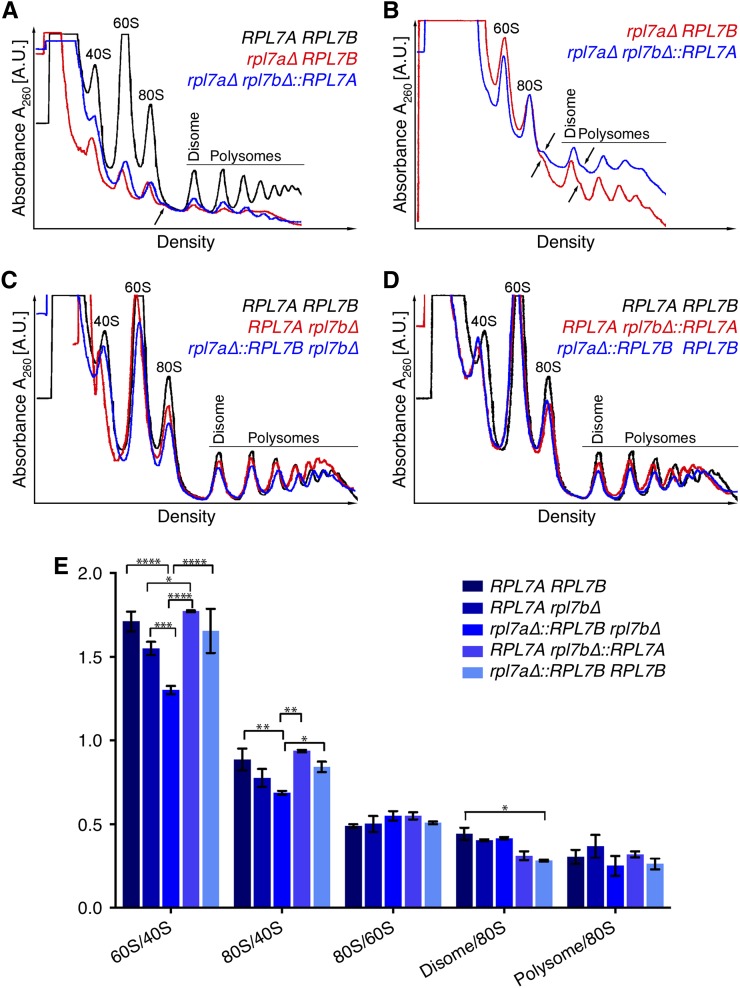
Primarily the RPL7 locus, but also the Rpl7 and snR39/59 isoforms expressed, contributes to differences in polysome profiles. Polysome profiles of cell extracts from strains of the indicated genotype grown in YPD broth at 20°, and fractionated in 10–50% (w/v) sucrose gradients. Absorbance units at 254 nm from the top to the bottom of the gradient for each genotype are shown in each graph. The same trace of the RPL7A RPL7B strain is displayed in black in (A), (C), and (D) to facilitate comparisons between panels. (A) Polysome profiles of the mutants with the RPL7B (red), or RPL7A (blue), CRI at the RPL7B locus are shown, and the genotypes indicated. Traces of the two mutants and the RPL7A RPL7B strain were overlaid by aligning the lowest point of each trace between the 80S monosome peak and the disome peak. The sensitivity setting of the UV monitor was 0.2. The arrow points to a minor peak of halfmer polyribosomes on the right shoulder of the 80S peak in rpl7a∆ RPL7B and rpl7a∆ rpl7b∆::RPL7A mutants. (B) Reanalysis of the rpl7a∆ RPL7B and rpl7a∆ rpl7b∆::RPL7A mutants, with the UV monitor at a more sensitive setting of 0.1, and profiles normalized to the 80S peak for better resolution of the halfmer polyribosome peaks, which are indicated by arrows. The 40S peak cannot be resolved at this sensitivity setting. (C, D) Polysome profiles of mutants of the indicated genotypes with the RPL7A (red), or RPL7B (blue), CRI at the RPL7A locus. In each panel, traces of three strains were overlaid by aligning the lowest point of each trace between the 80S monosome peak and disome peak. The sensitivity setting of the UV monitor was 0.2. (E) A graph of relative levels of 60S ribosomal subunits, 80S monosomes, disomes, and polysomes in three biological replicates of each strain of the indicated genotype. To normalize for differences in lysis efficiency and lysate amount, the heights of 40S, 60S, 80S, disome, and highest polysome peaks in polysome profiles were measured, and ratios indicated on the y-axis were calculated. Statistically significant differences in the indicated ratios between strains of different genotypes, as determined by a two-way ANOVA test, are indicated with asterisks. *P < 0.05, **P < 0.01, ***P < 0.001, ****P < 0.0001.